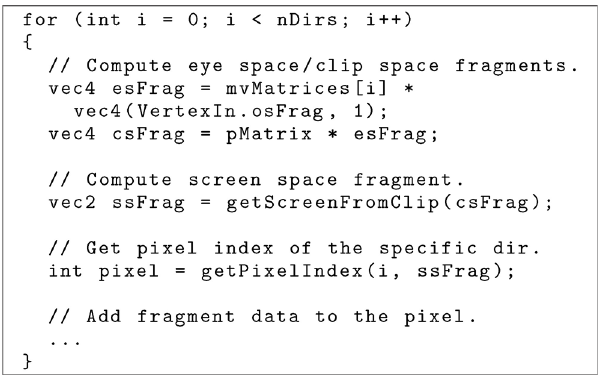
Fig. 4 Per-pixel blue/red/green, blue/green, and blue/red fragment colors stored in linearised